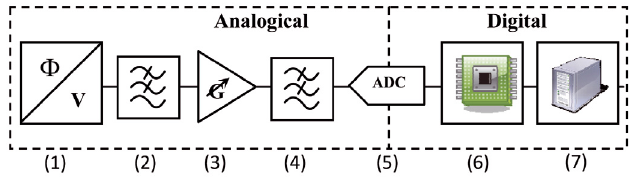
Fig. 7. Block diagram of the acquisition card.